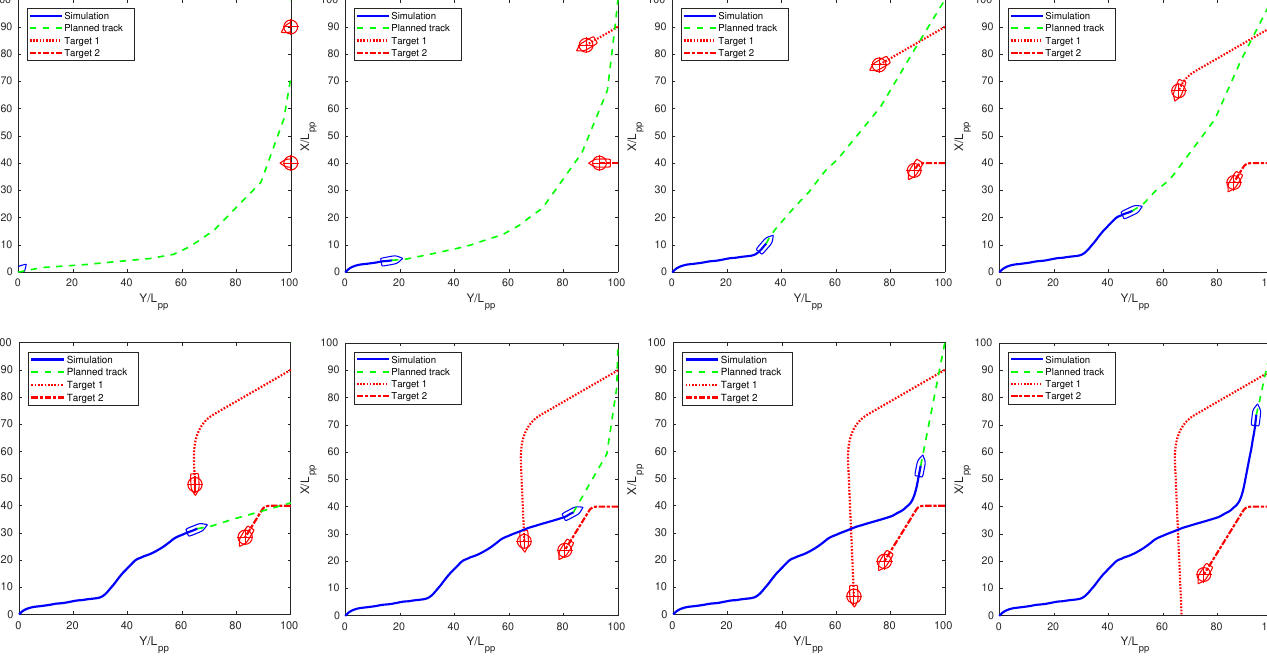
Figure 15. Scenario 2: simulation of a COLREG-compliant manoeuvre with unexpected target behaviour (both targets changing